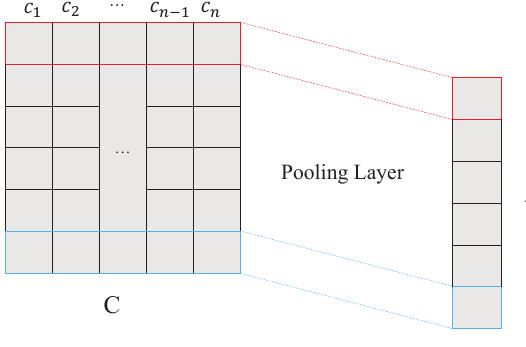
Figure 3. Pooling Process in the Aggregated Strategy.